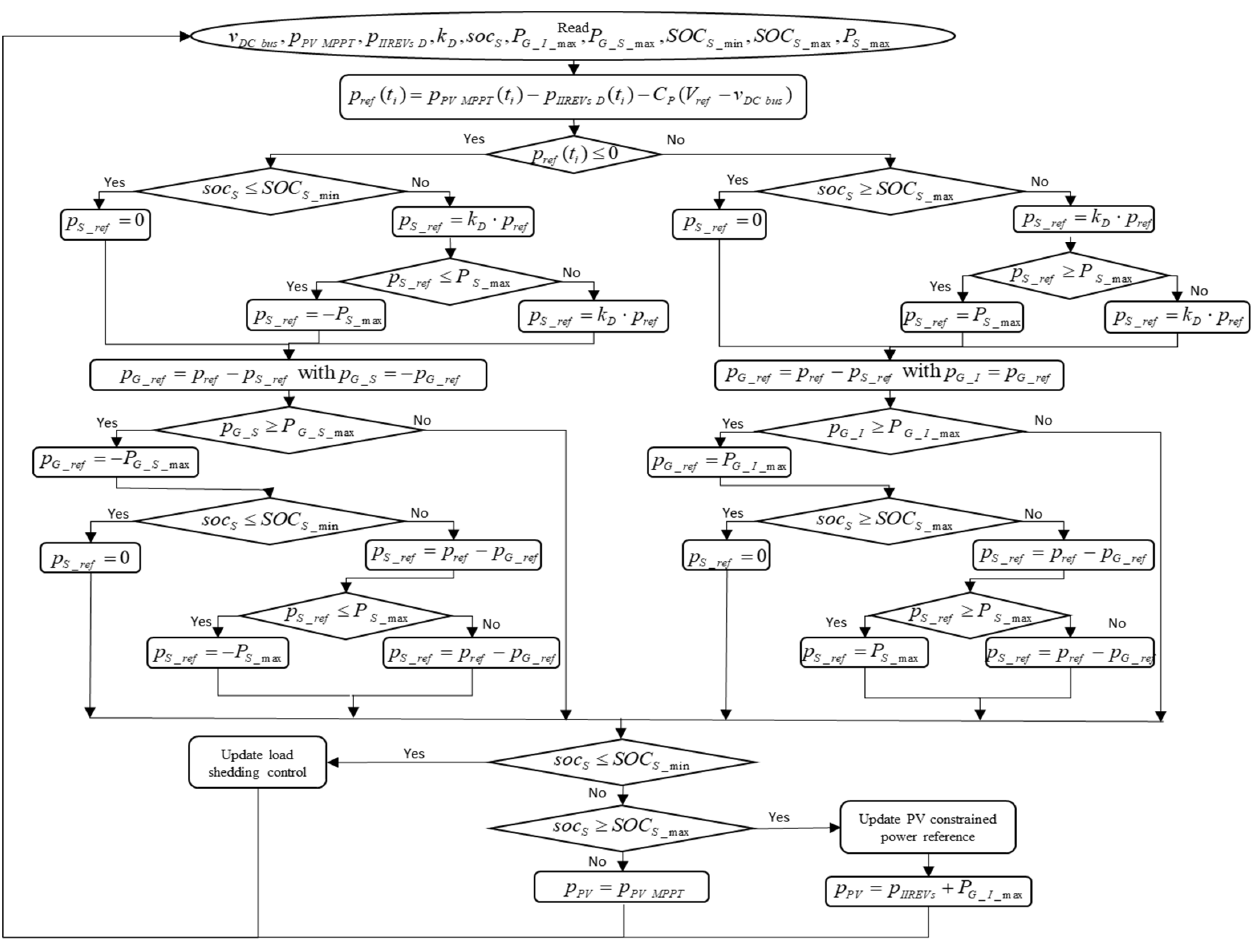
Figure 4. Control algorithm for IIREVs.